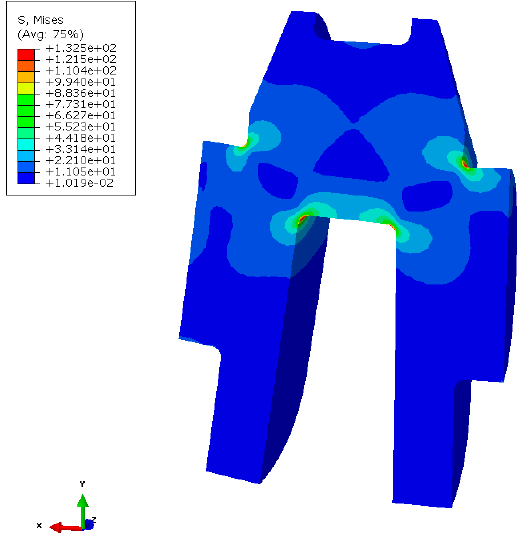
Figure 14. The Von Mises stress distribution of the crankshaft (under the given load). Table 4. The stress and strain components of the crankshaft (under the given load).